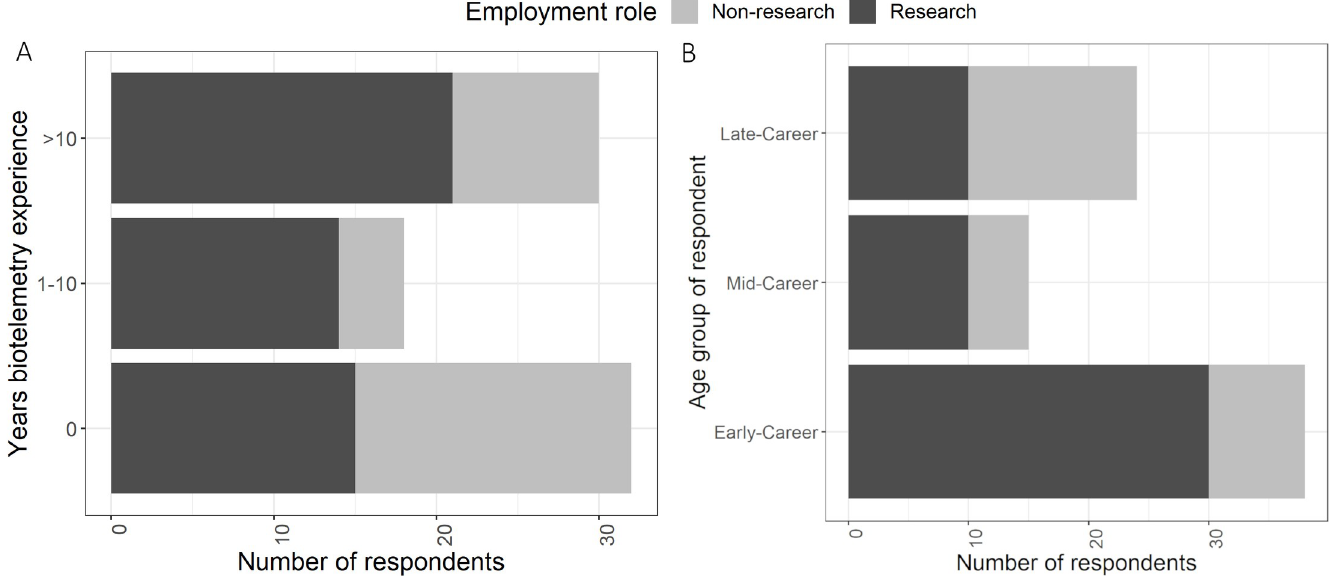
Fig 1. Distribution of respondents among A) biotelemetry experience, B) age group, with respondents classified as either in research-focused (dark grey) or non- research-focused (light grey) employment.